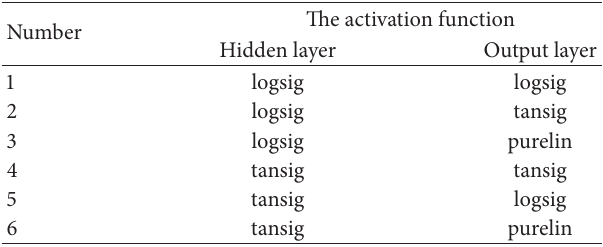
Table 4: The variable activation functions in the